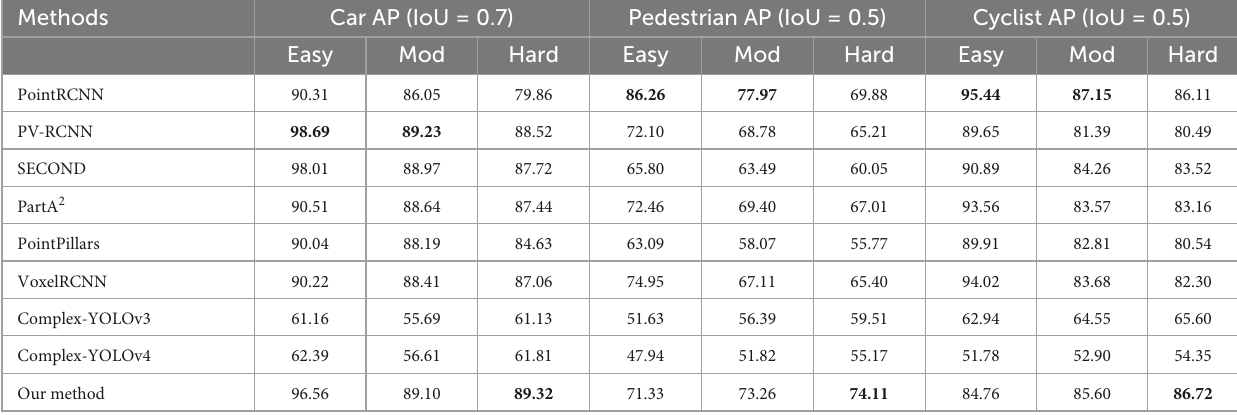
TABLE 5 Experimental results of comparison experiments with other algorithms. Methods